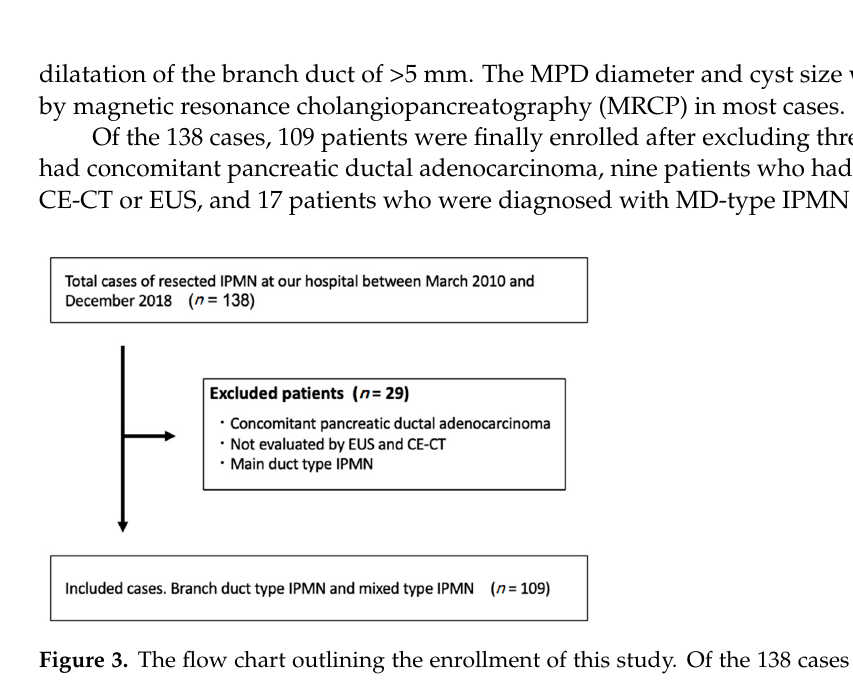
Figure 3. The flow chart outlining the enrollment of this study. Of the 138 cases who underwent surgical resection for IPMN, 109 patients were finally enrolled after excluding three patients who had concomitant pancreatic ductal adenocarcinoma, nine patients who had not undergone contrast-enhanced CT (CE-CT) or EUS, and 17 patients who were diagnosed with MD-type IPMN. EUS, endoscopic ultrasound; CT, computed tomography, IPMN, intraductal papillary mucinous neoplasm; MD, main pancreatic duct.